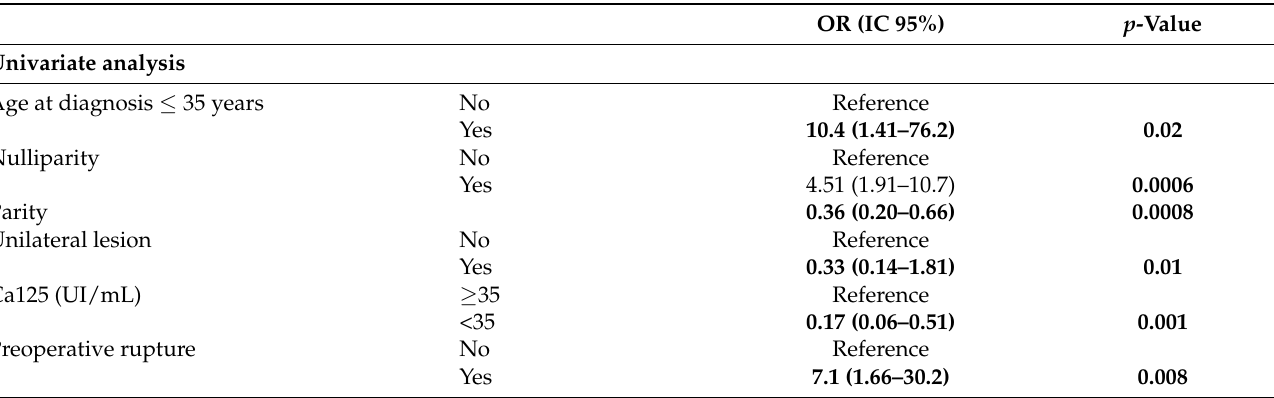
Table 5. Risk factors for recurrence in univariate and multivariate